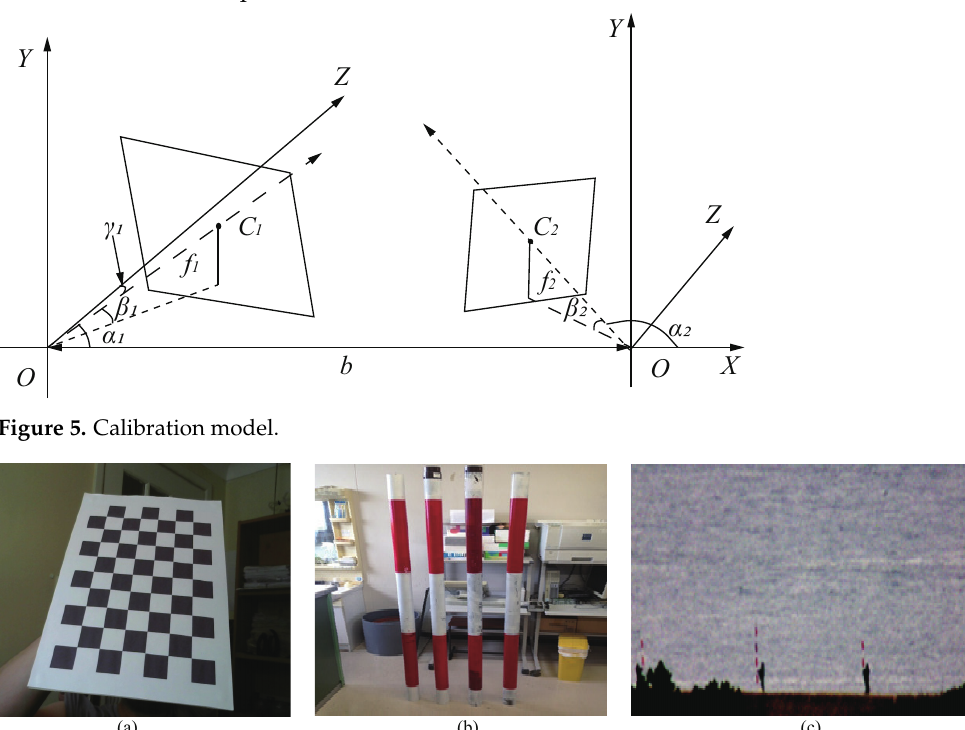
Figure 6. Calibration tools: ( a ) standard calibration board, ( b ) proposed calibration bar used in long-distance calibration, ( c ) one of the calibration experiment image using the calibration bar (on the Shingu coast, shooting from Fukuoka Institute of